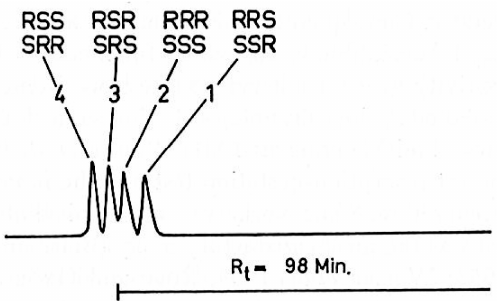
Figure 4. Gas chromatogram of all- rac - α -Toc-ME. The four pairs of diastereomers of all- rac - α -Toc-ME have equal peak height [44]. Reprinted with permission. Copyright (1981) by Hogrefe.